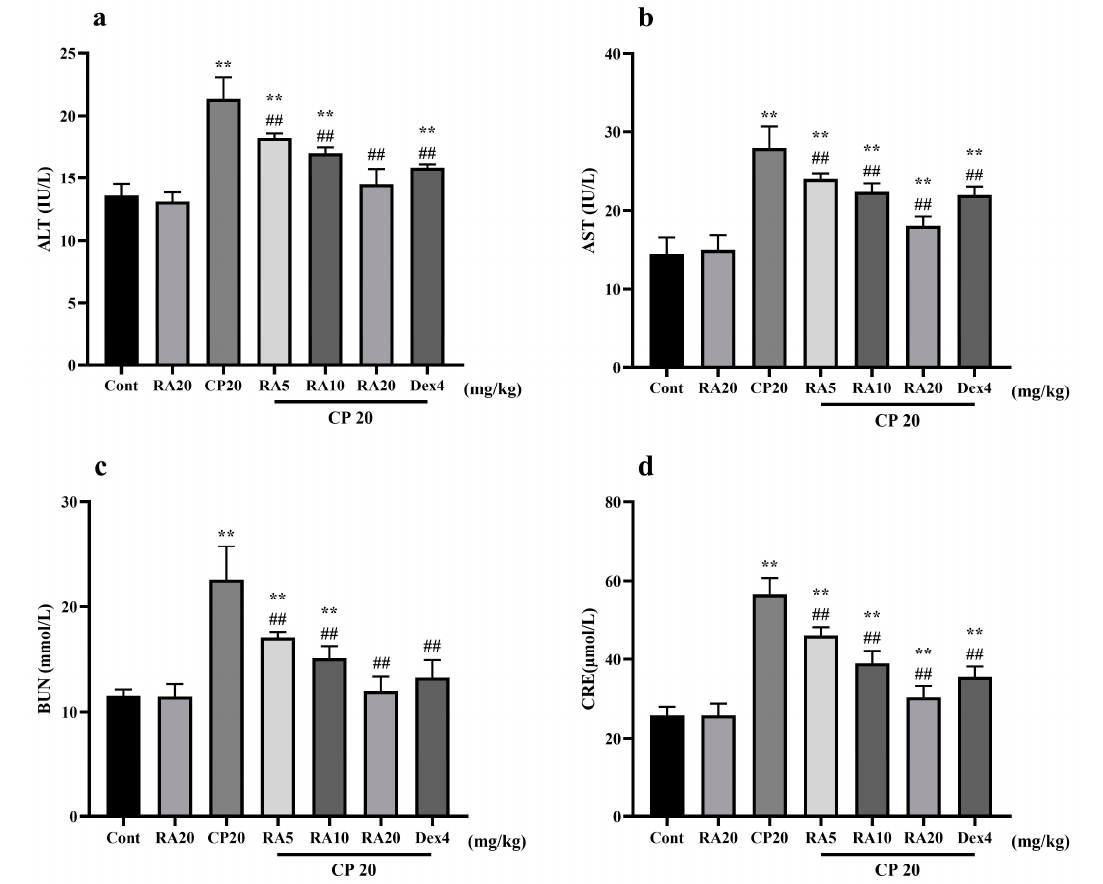
Figure 2. The effect of RA on the liver and kidney function indices ALT, AST, BUN, and CRE in CP-induced ALI mice. The expression levels of the liver function indices AST and ALT ( a , b ) and the kidney function indices BUN and CRE ( c , d ) were detected by ELISA. These experiments were repeated three times. ** and ## denote highly significant differences ( p < 0.01) compared with the control and CP model groups, respectively.